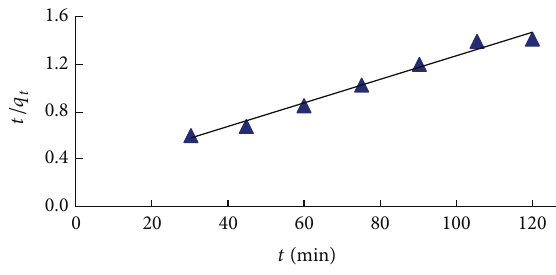
Figure 4: The relationship between 𝑡/𝑞 𝑡 and 𝑡 .